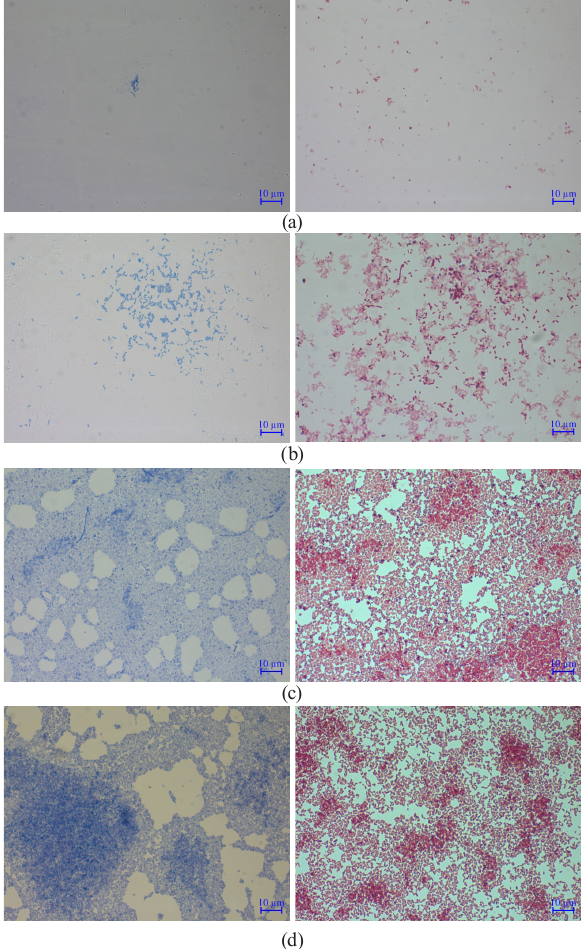
Figure 3 Micrographs of biofilms formed in sweet whey permeate in: (a) 8 h, (b) 24 h, (c) 48 h, and (d) 72 h. Methylene blue staining (left) and Gram-staining (right).